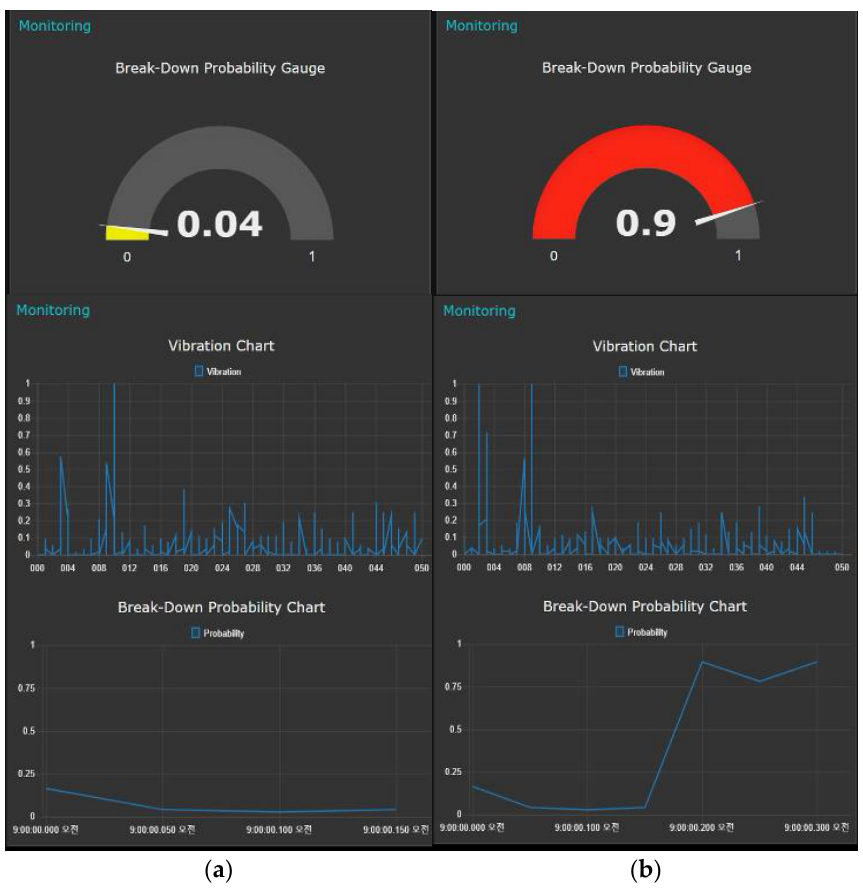
Figure 4. Dashboard of the fault monitor: ( a ) normal states; ( b ) fault states.